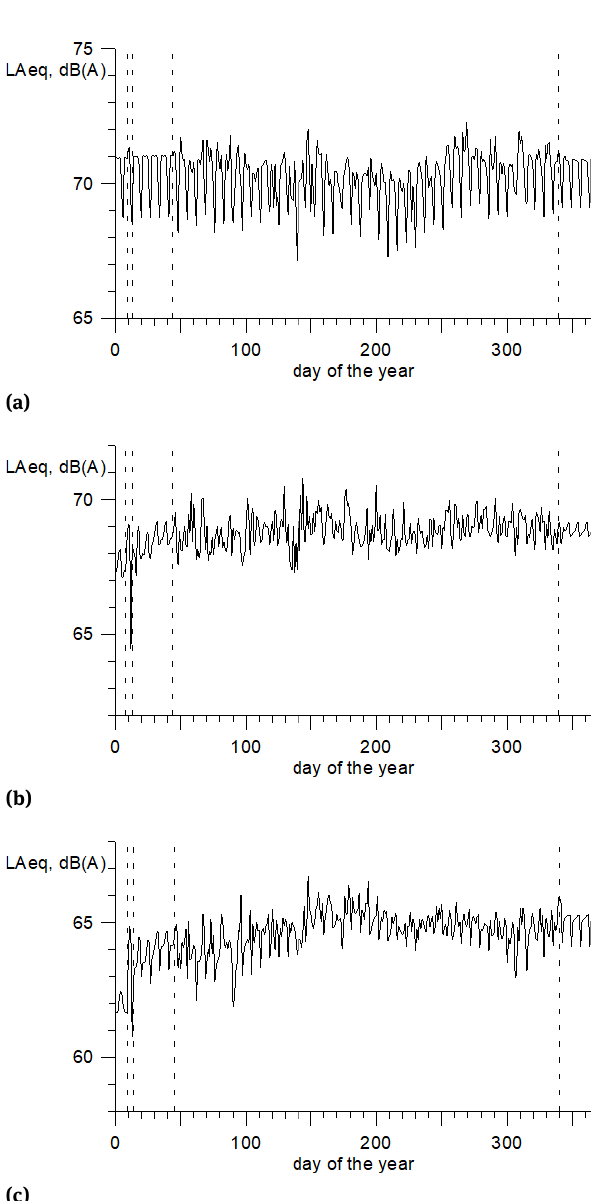
Figure 2: L Aeq calculated by the model for the location no. 1: (a) day sub-interval (6-18), (b) evening (18-22), and (c) night (22-6) in year